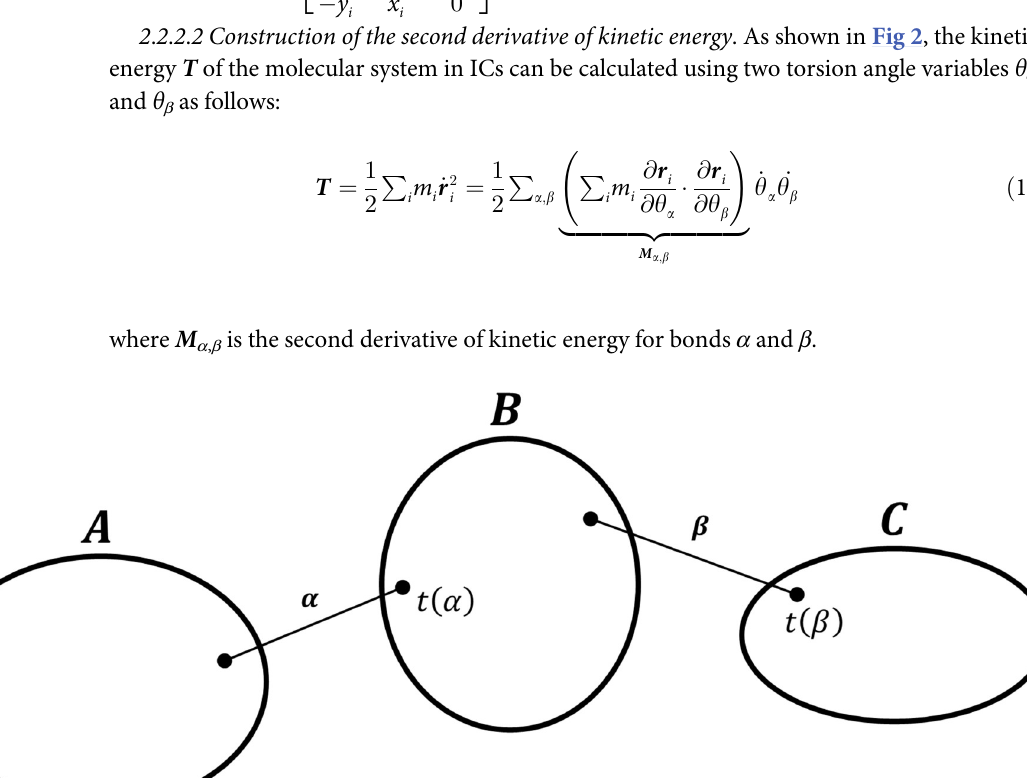
PLOS ONE | https://doi.org/10.1371/journal.pone.0258818 November4,